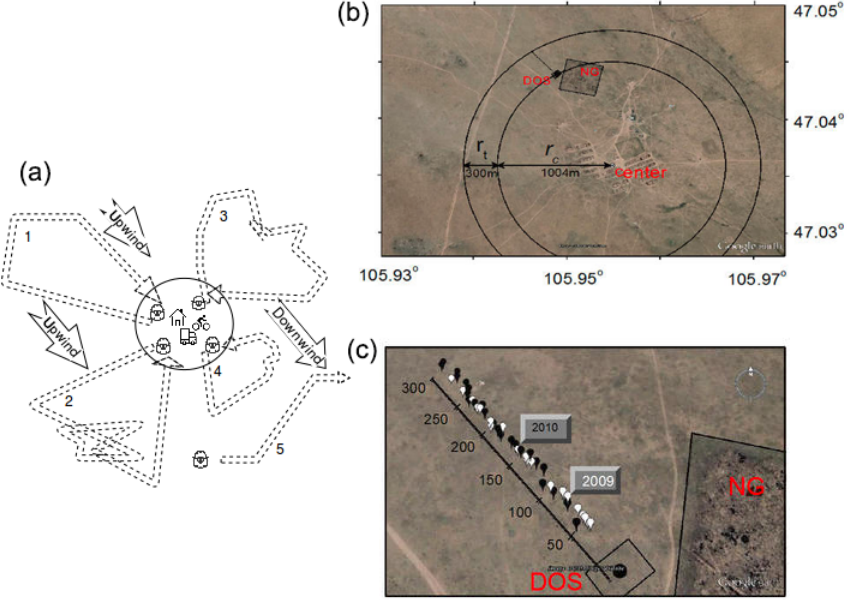
Figure 2. Experimental settings. (a) Schematic grazing or trampling routes are divided into three types regarding grazing routines. The grazing routines are irregular yet depend on climatic seasons (weather condition) and fodder sources. Therefore, it is assumed that Type I routes (marked by 1, 2, and 3) are usually used when weather conditions are good and rich fodder is available. The Type II route (marked by 4) is usually used during bad weather conditions, such as in spring and winter. The Type III route (marked by 5) is called otor . (b) Annulus area selected for this study. r c is the distance from the sum center (center) to the inner circle for the selected annulus and r t is the width of annulus area. (c) PI-SWERL ® experimental test areas (transect lines; and dust observation site, DOS). White and dark balloons present dust sampling points along the transect in 2009 and